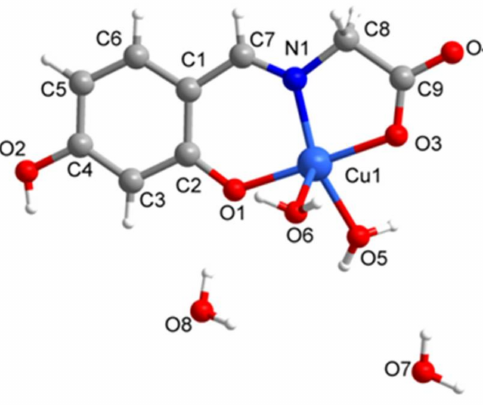
Figure 1. The crystal structure of Complex 1 .